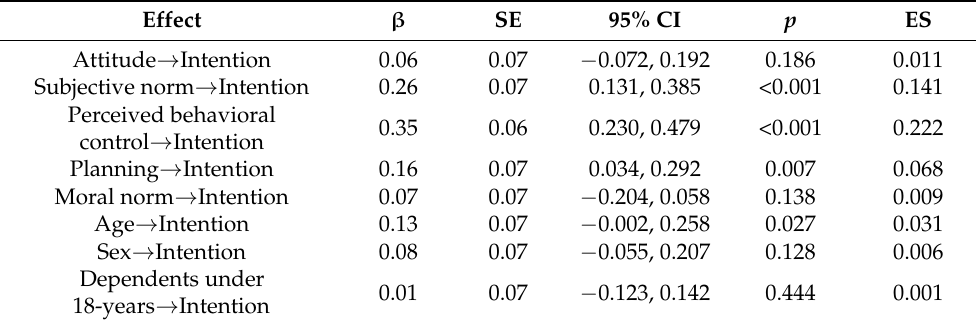
Figure 1. Structural equation model predicting intention to avoid driving into floodwater ** p < 0.01.